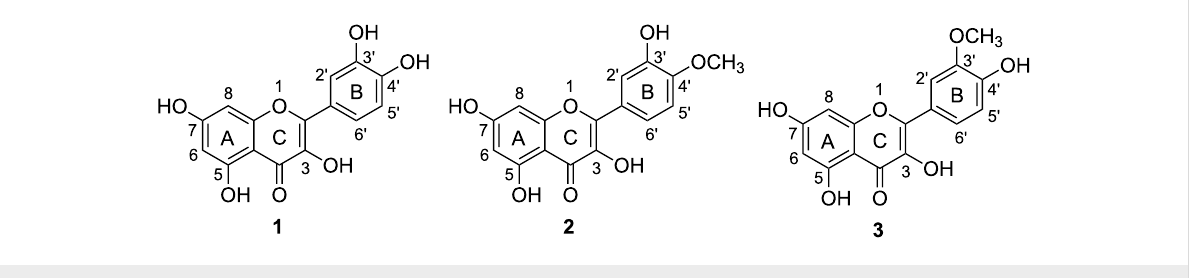
Figure 1: Structures of quercetin and methylated metabolites.